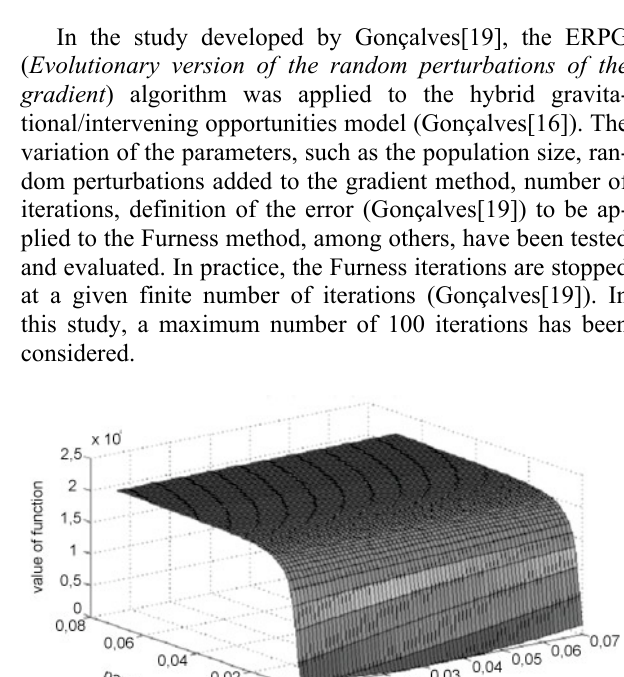
Fig. 7 – Function defined by the Maximum Likelihood crite- ria (Bez[6])